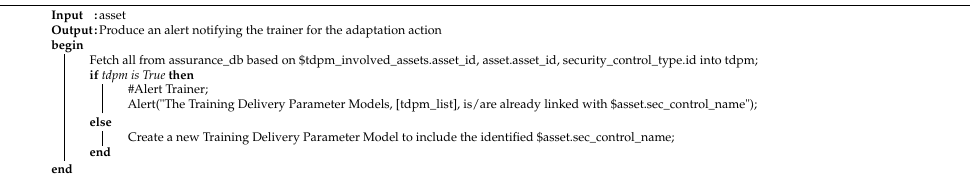
Algorithm 1: Adaptation based on security controls